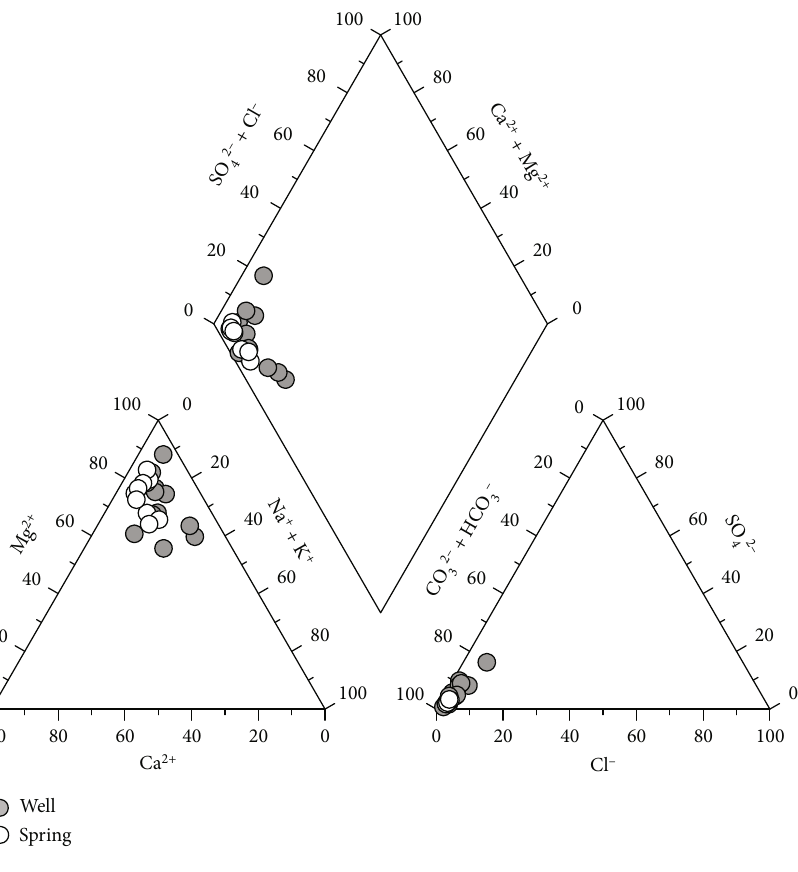
Figure 5: Piper diagram.